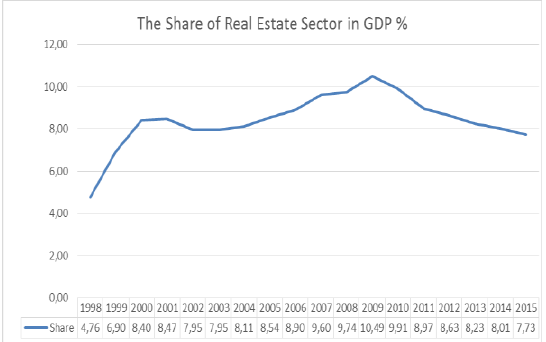
Figure 5. Share of Real Estate Activities in GDP Source: TUİK